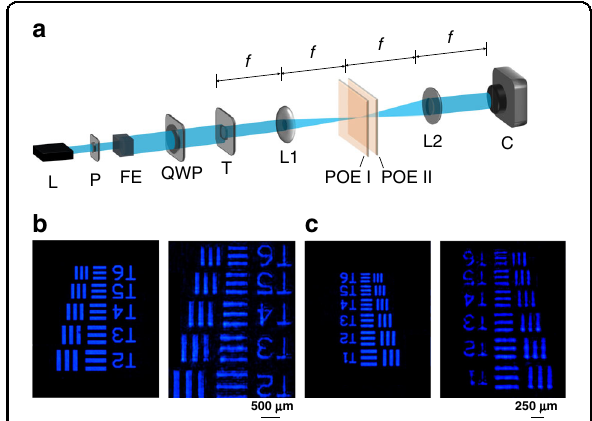
Fig. 5 Miniature planar telescope wavefront characterization. a Schematic of the measurement setup. A 488-nm circularly polarized laser beam is incident on the 1951 USAF resolution test chart which is then imaged by a 4 f system. A planar telescope module composed of an f /3.3 POE I and an f /2 POE II is placed on the 2 f plane. Images with and without the planar telescope module are recorded. L laser, P polarizer, FE fi ltering and expansion, QWP quarter-wave plate, T test chart, L1 lens I, L2 lens II, C camera. The focal length of L1 and L2 is 15 cm. b Captured images of group 2 of resolution test chart without (left) and with (right) planar telescope. c Captured images of group 3 of resolution test chart without (left) and with (right) planar